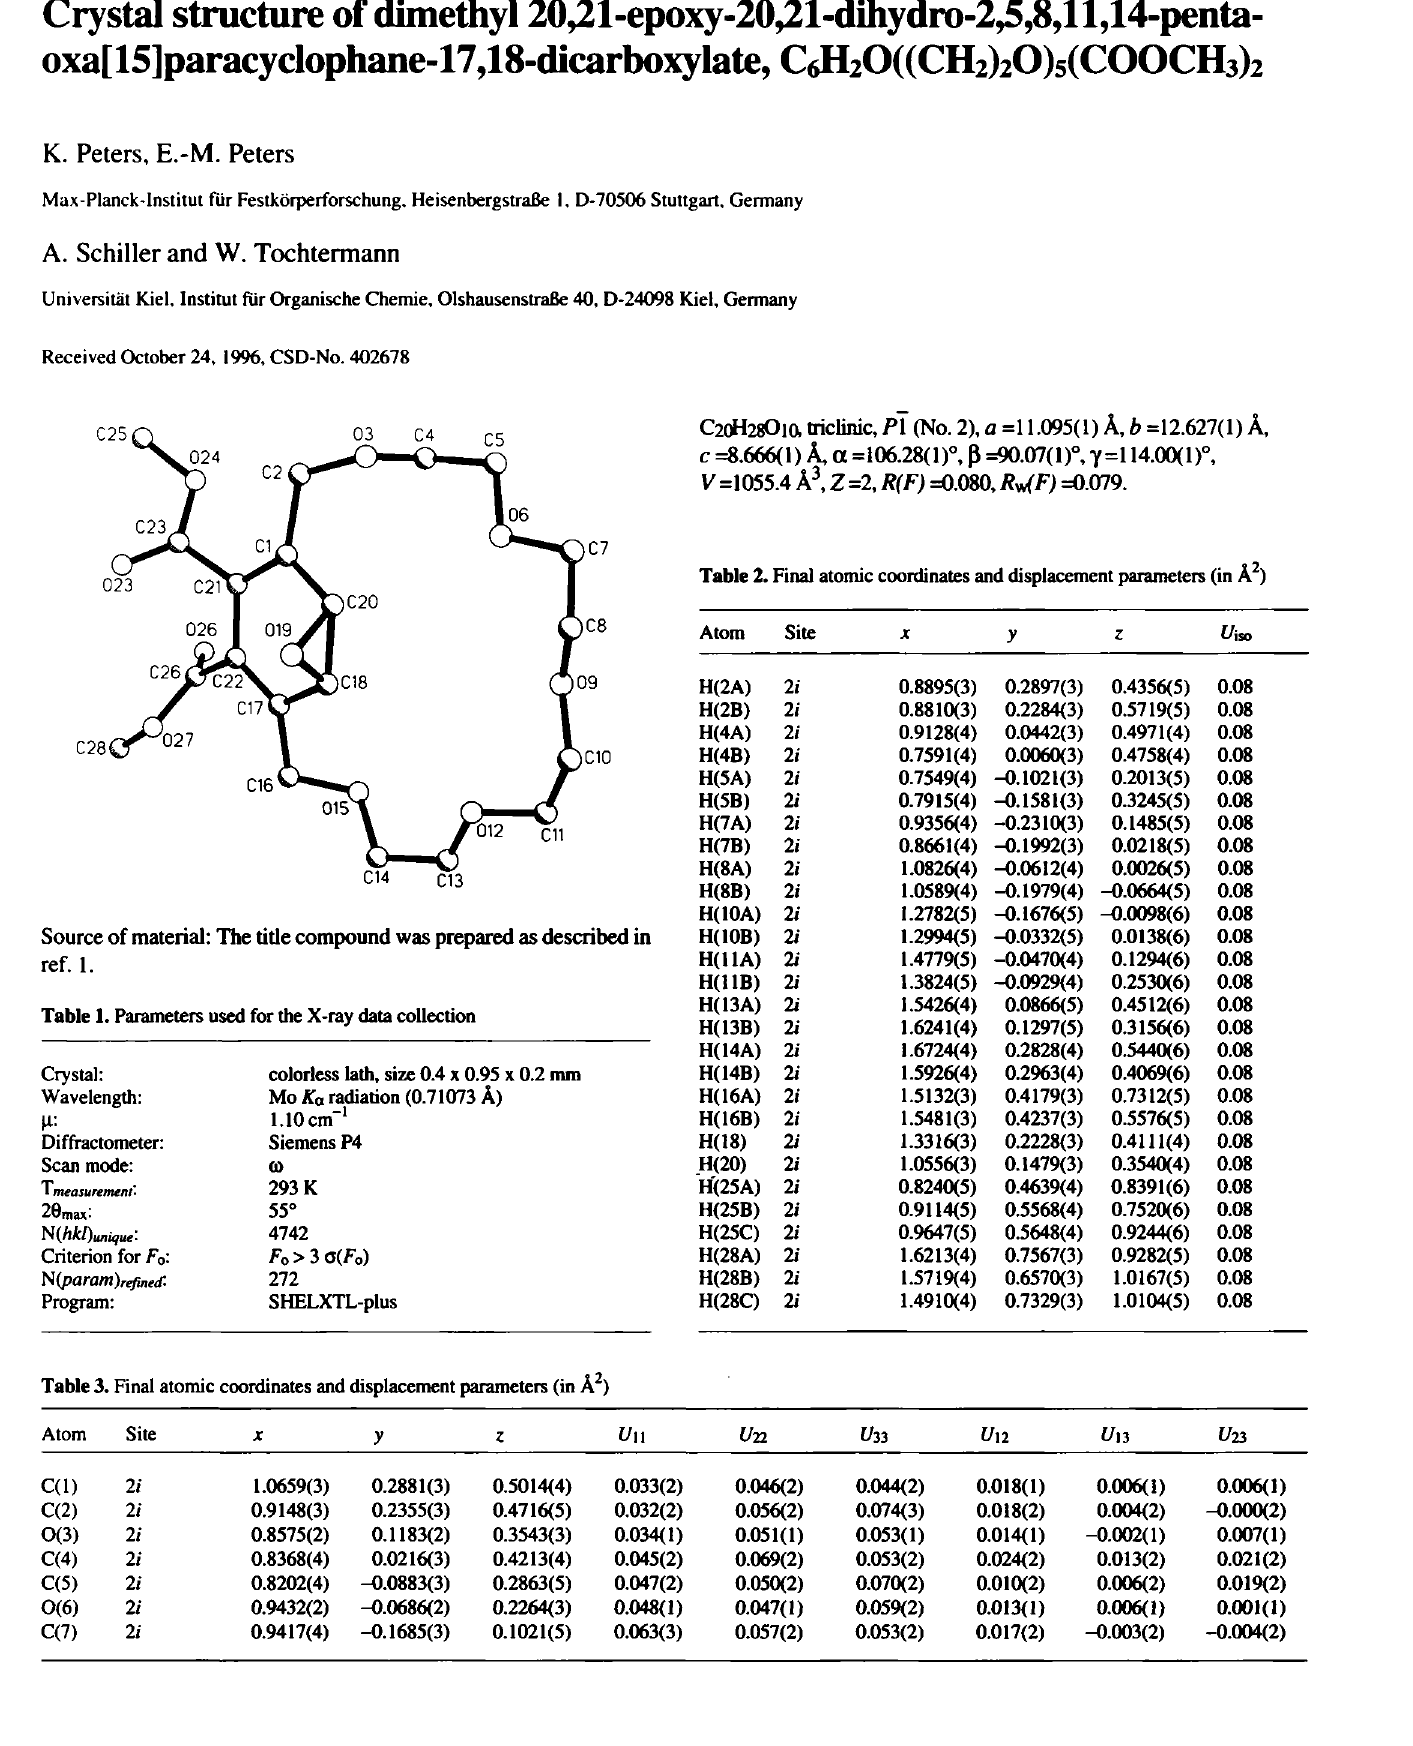
Table 2. Final atomic coordinates and displacement parameters (in Â 2 )